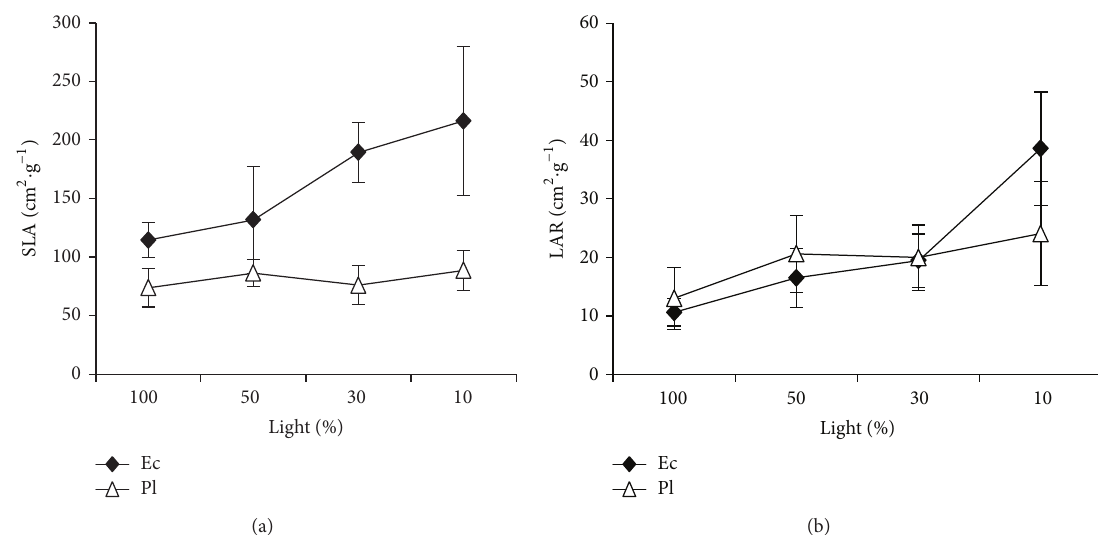
Figure 3: Leaf morphology responses to light for two rain forest tree species. Figures refer to (a) specific leaf area and (b) leaf area ratio.